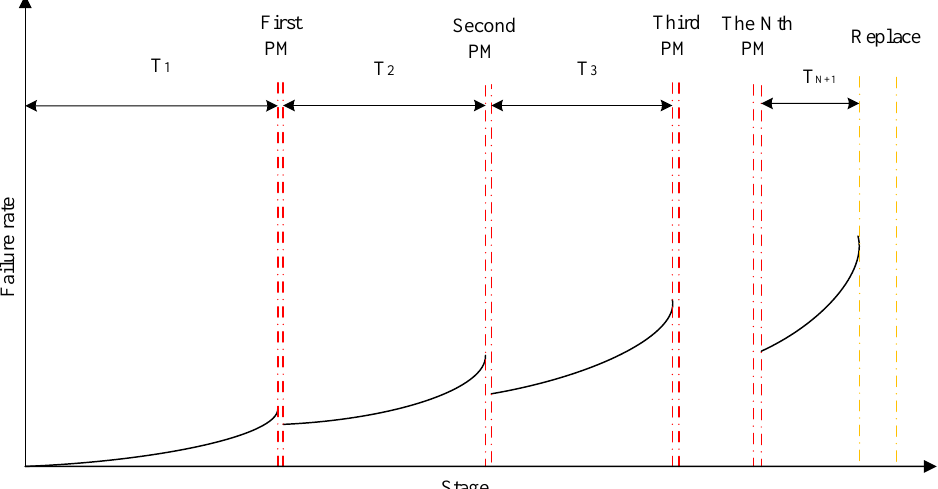
Figure 1. The variation in equipment failure rates and maintenance actions.